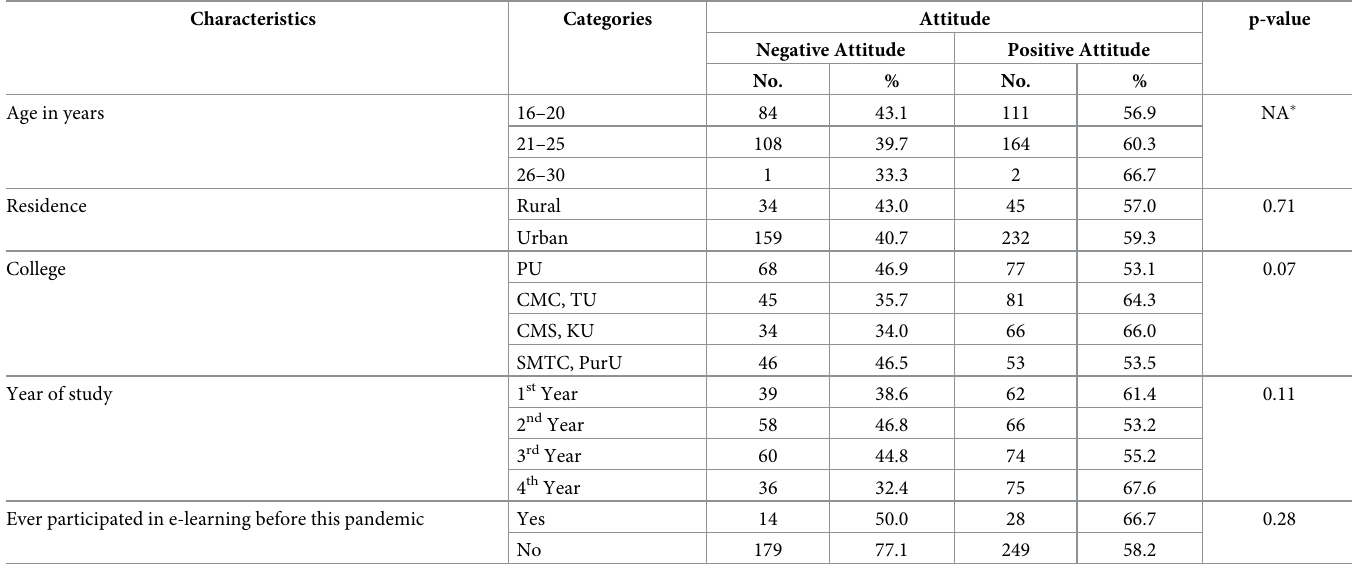
Table 10. Association of attitude regarding e-learning with selected socio-demographic variables (n = 470).